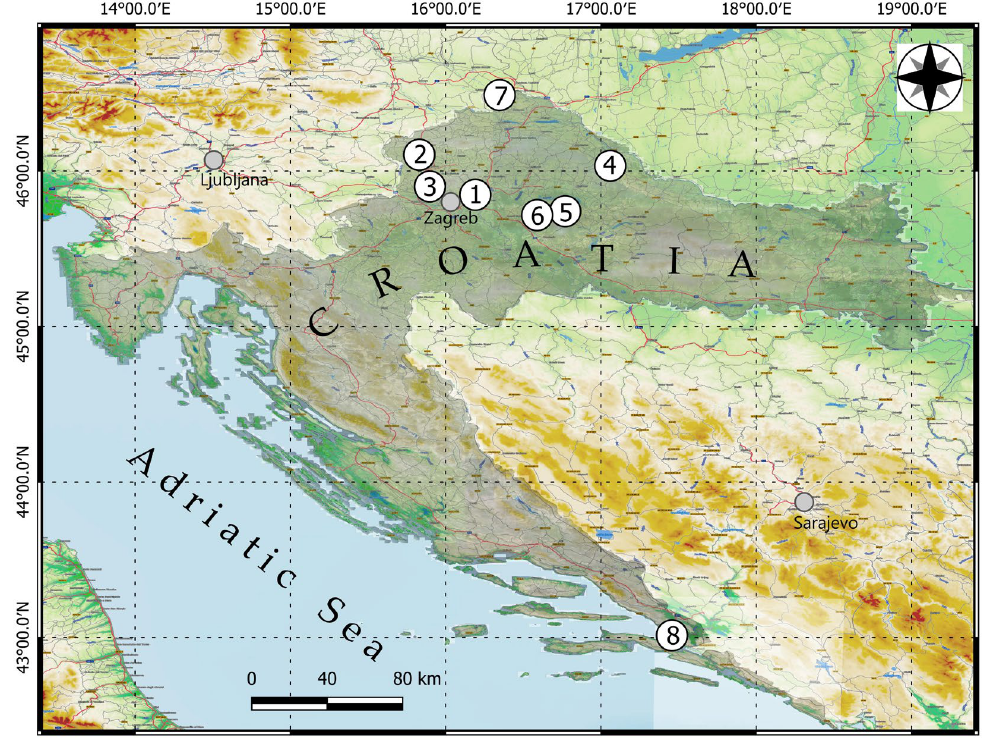
Figure 1. Map of the study sites in the regions of Croatia (numbering of the sites according to the list in Table 2).